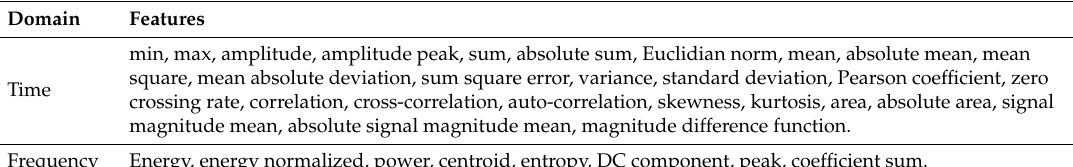
Table 2. List of time and frequency domains